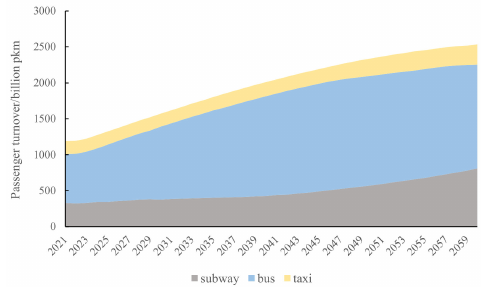
Figure 4. Inner-city passenger turnover.